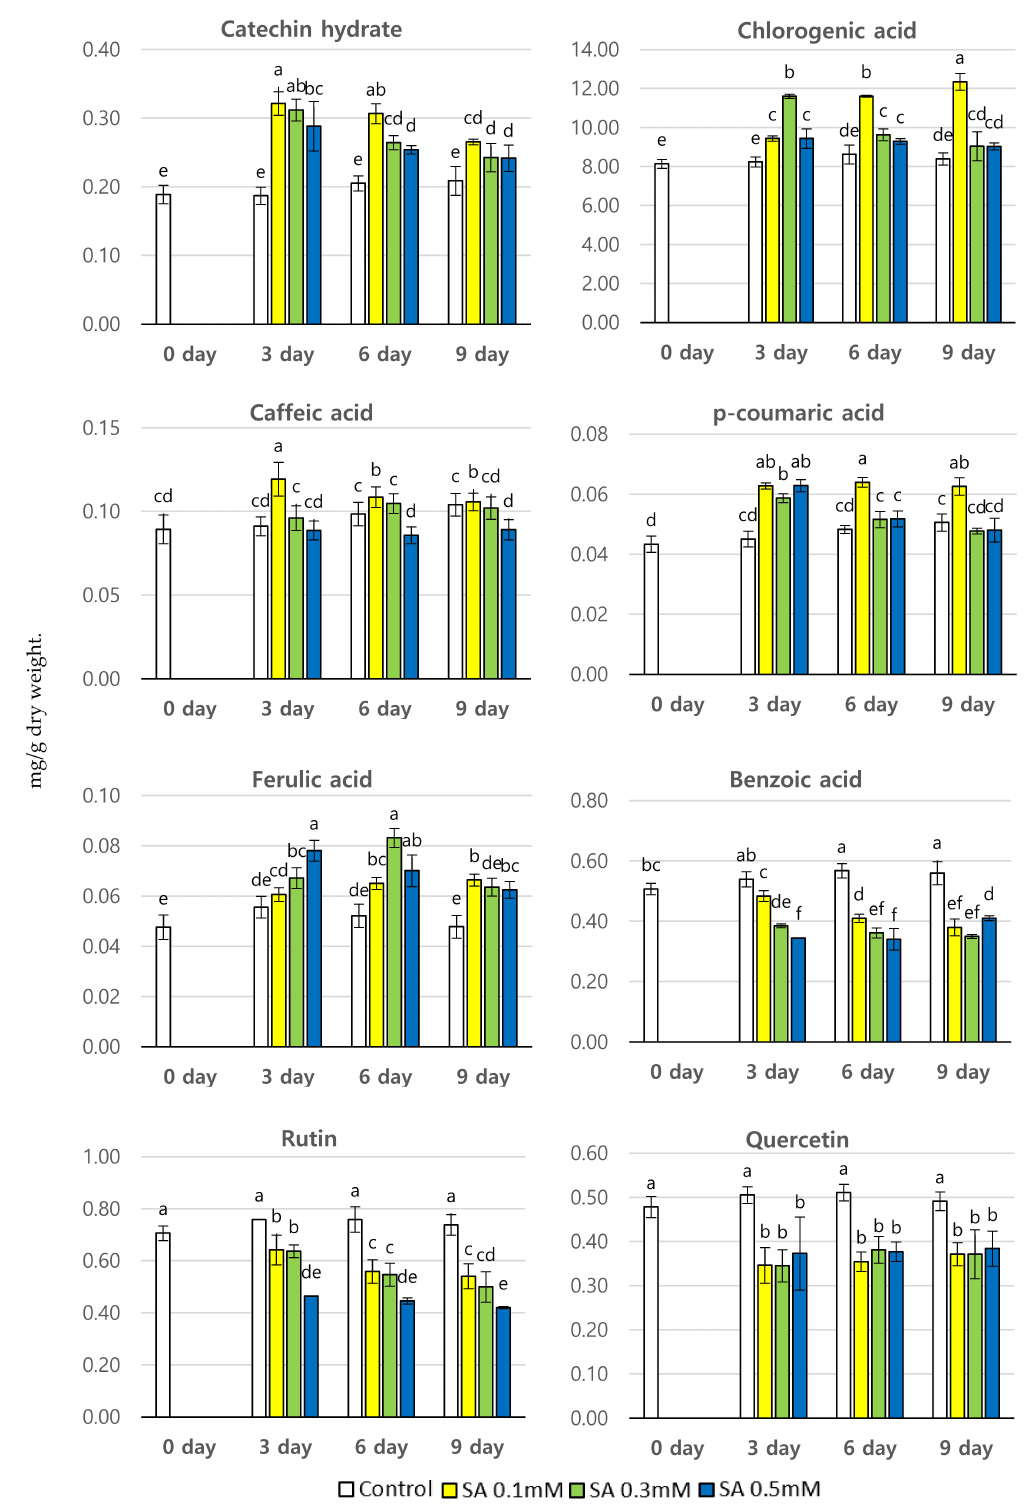
Figure 3. The content of phenolic compounds (mg / g dry wt.) in P. brachycarpa Nakai samples after treatment with di ff erent concentrations of salicylic acid (SA). The values marked above the bars with di ff erent letters (a–f) indicate a statistically significant di ff erence between treatments, as determined using DMRT ( p <